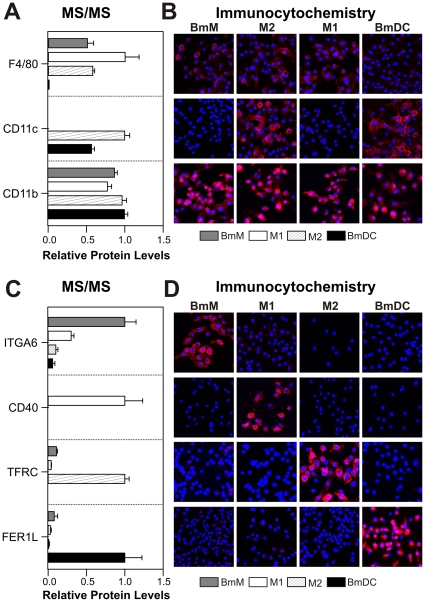
Immunocytochemical detection of plasma membrane protein markers.Expression levels of widely used plasma membrane protein markers (Panels A–B) and newly identified markers (Panels C–D) of M1 cells, M2 cells, BmMs, and BmDCs were assessed by mass spectrometry (Panels A,C) and immunocytochemistry (Panels B,D). For MS/MS, proteins were quantified by spectral counting and expressed relative to the cell type with the highest expression level for each protein. Results are means and SDs. Cells were stained with antibodies specific to each protein (red channel), counterstained with DAPI to visualize nuclei (blue-channel), and examined by confocal microscopy. Immunostaining and microscopy were performed on the same day with identical microscope settings. Results are representative of 3 independent analyses.